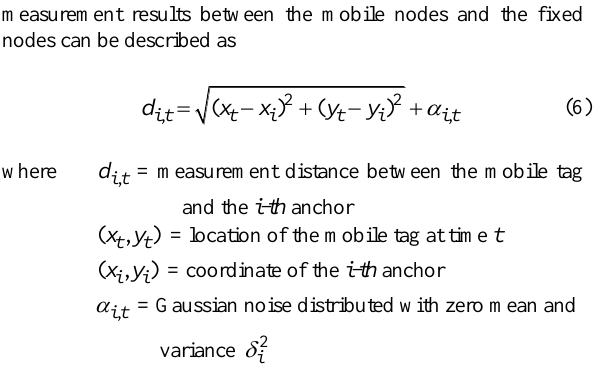
Figure 2. Error distribution on static ranging at 10 m apart between tag and anchor (reply = 3